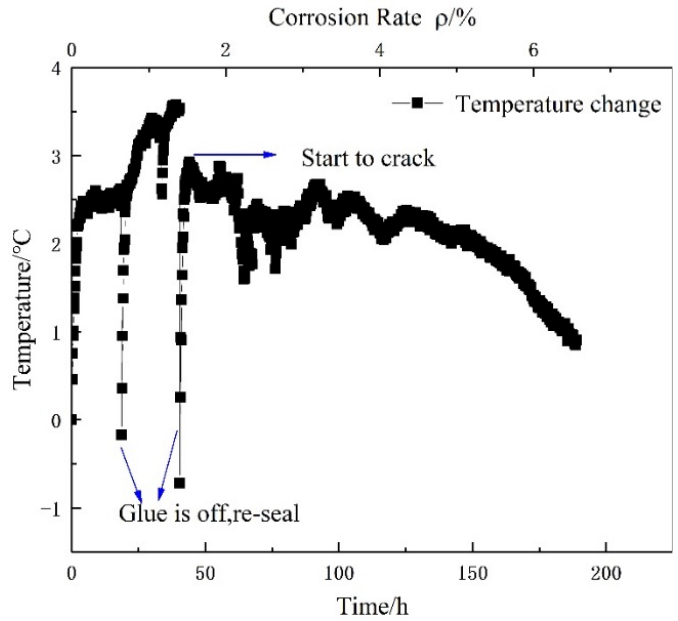
Figure 9. Temperature of rebar in electro-accelerated corrosion of 2-150# specimen.